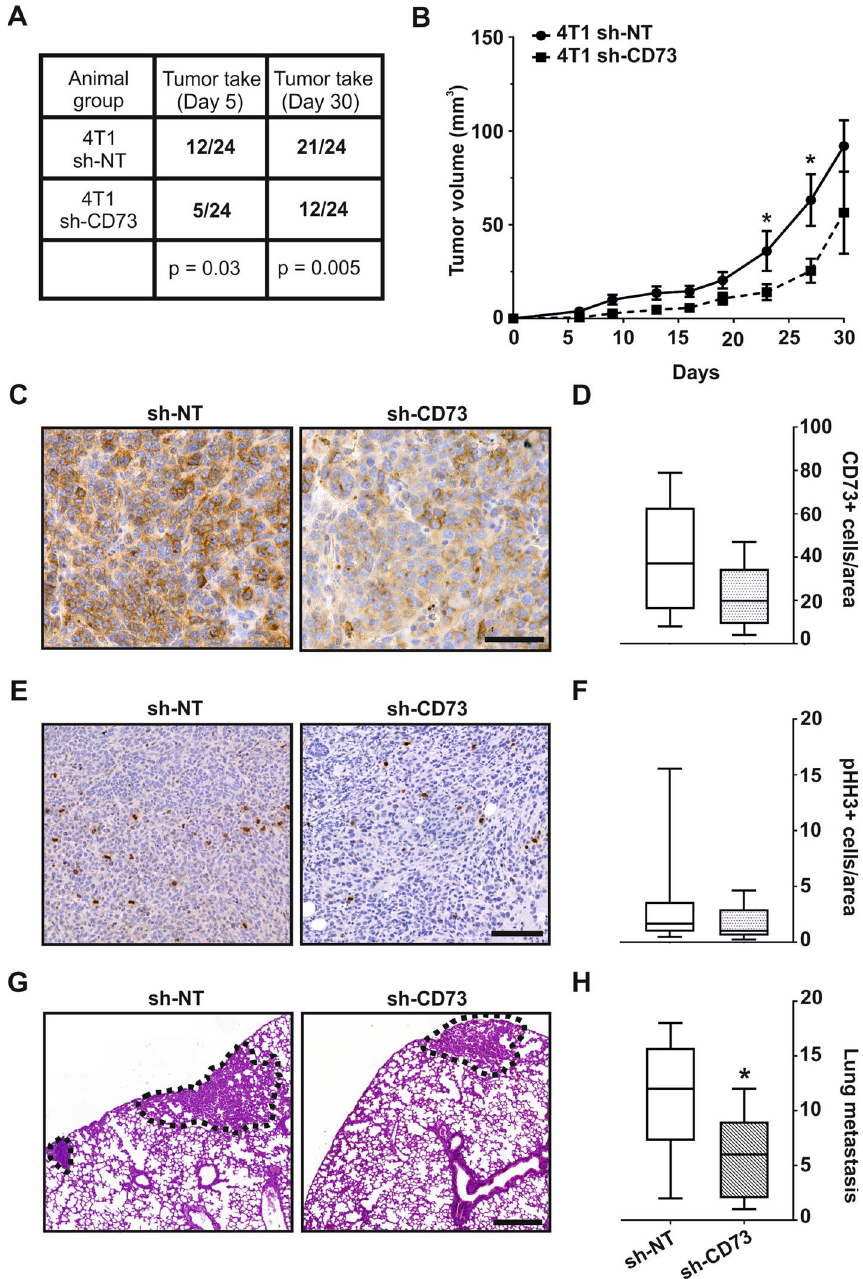
Figure 5. CD73 suppression inhibits tumor take, growth and lung metastases. ( A ) sh-NT and sh-CD73 4T1 cell tumor take rates. The numbers indicate formed tumors per 24 tumor inoculations. P-values were analyzed by Chi-Square test. ( B ) sh-NT and sh-CD73 tumor growth demonstrated as a function of time. ( C ) Representative images of CD73-positive cells in sh-NT and sh-CD73 tumors. Scale bar 100 µm. ( D ) Percentage of CD73- positive cells from 4T1 sh-NT and sh-CD73 tumors. ( E ) Representative images of pHH3-positive cells as an indicator of proliferation in sh-NT and sh-CD73 tumors. Scale bar 200 µm. ( F ) Percentage of pHH3-positive cells from 4T1 sh-NT and sh-CD73 tumors. Immunohistochemical staining expressions were quantified by QuPath. ( G ) Representative H & E stainings from the lungs of tumor bearing mice, metastases are indicated with dotted line. Scale bar 500 µm. ( H ) Numbers of lung metastases from sh-NT and sh-CD73 groups. Data is expressed as mean ± SEM, by a two-tailed Student’s t-test. *P < 0.05; sh-CD73 vs. sh-NT